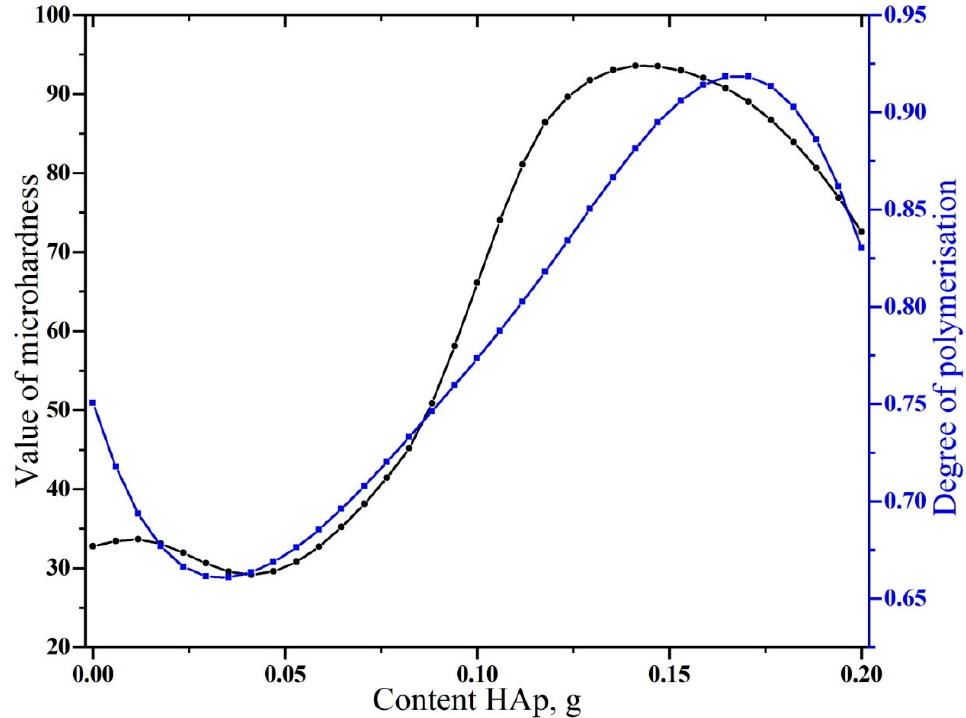
Figure 5. Comparison of the dependence of microhardness, H µ (VH), and degree of conversion of biomimetic adhesives on nanofiller admixture.